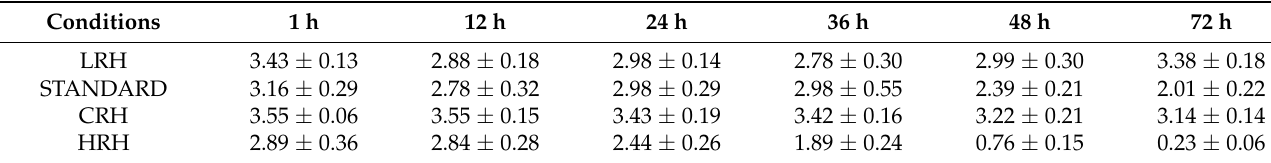
Table 3. Transverse strength with standard deviation [MPa] of studied cores stored under defined conditions: LRH—Low relative humidity, constant temperature—RH = 10% ± 5%, t = 25 ◦ C; STANDARD—Laboratory ambient conditions— RH = 60% ± 5%, t = 25 ◦ C; HRH—High relative humidity, constant temperature—RH = 90% ± 5%, t = 25 ◦ C; CRH— Constant relative humidity, low temperature—RH = 60% ± 5%, t = 10 ◦